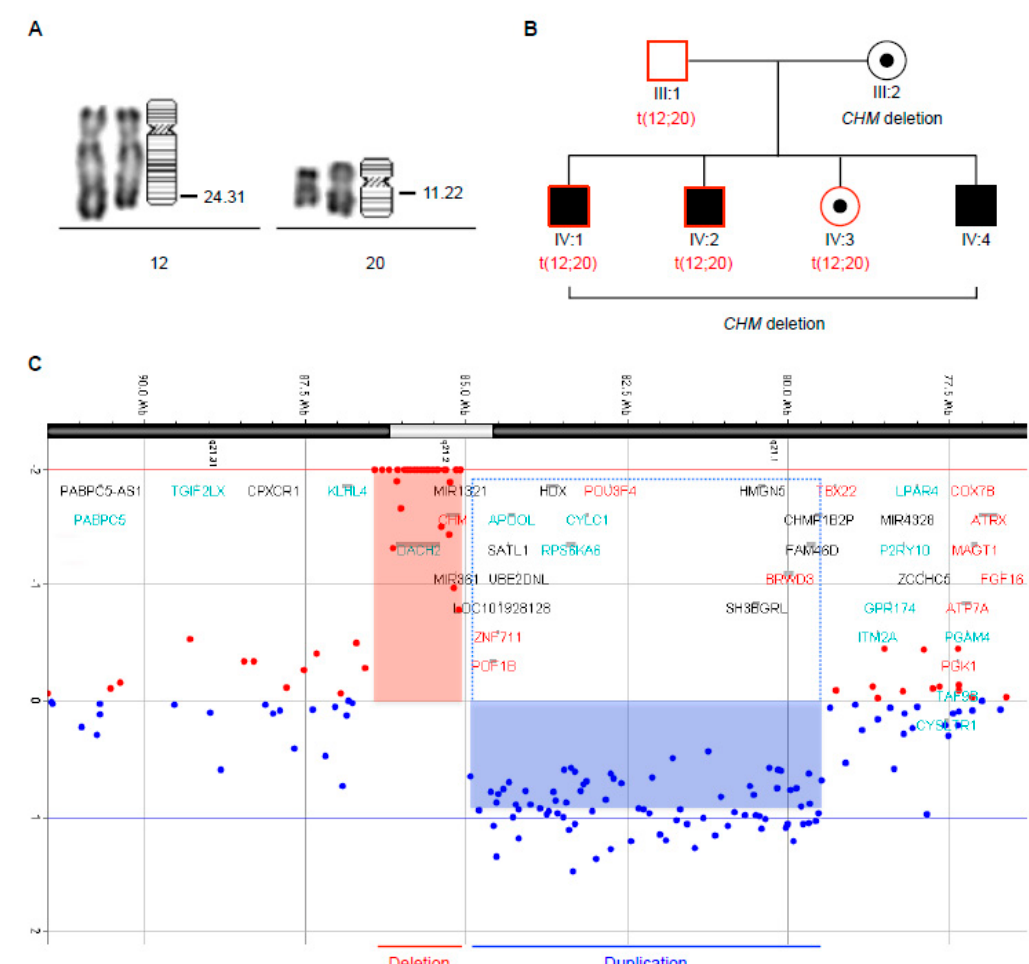
Figure 4. Analysis and segregation of chromosomal anomalies. ( A ) Partial karyotype by RHG banding of the fibroblasts of individual CHM5 and ideogram showing the breakpoints of the reciprocal translocation t(12;20)(q24.3;q11.2). ( B ) Results of blood karyotyping of all the individuals from